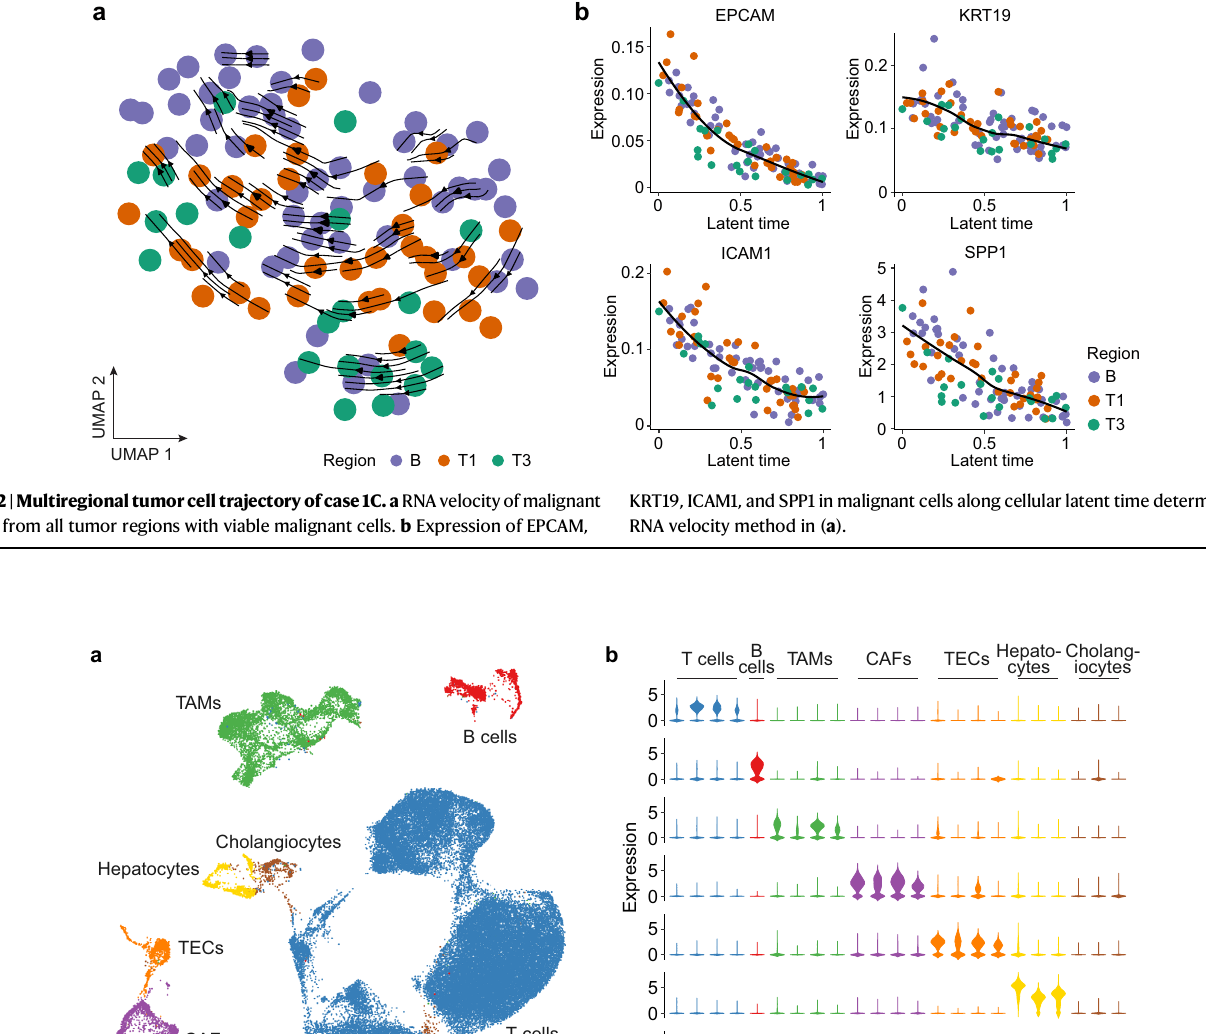
ofTcells( n =61,561)betweendifferenttumorregionsofeachindividualcase.Inthe boxplots,thecentralrectanglesspanthe fi rstquartiletothethirdquartile,withthe segments inside the rectangle corresponding to the median. Whiskers extend 1.5 times the interquartile range. Source data are provided as a Source data fi